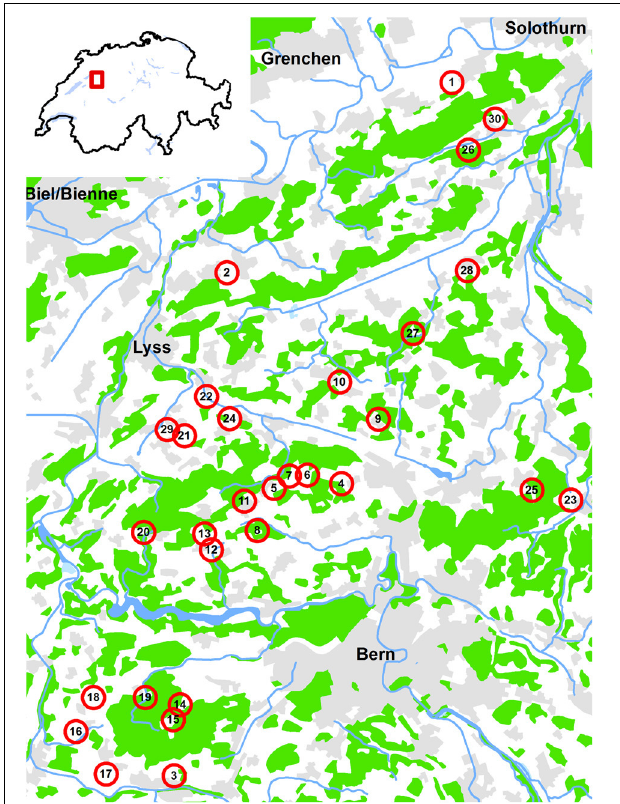
FIGURE 1 | Localisation of the 30 study sites in the Swiss lowlands. Green: forest; gray: settlements; blue: open water. Map background Vector 200 ©Swisstopo